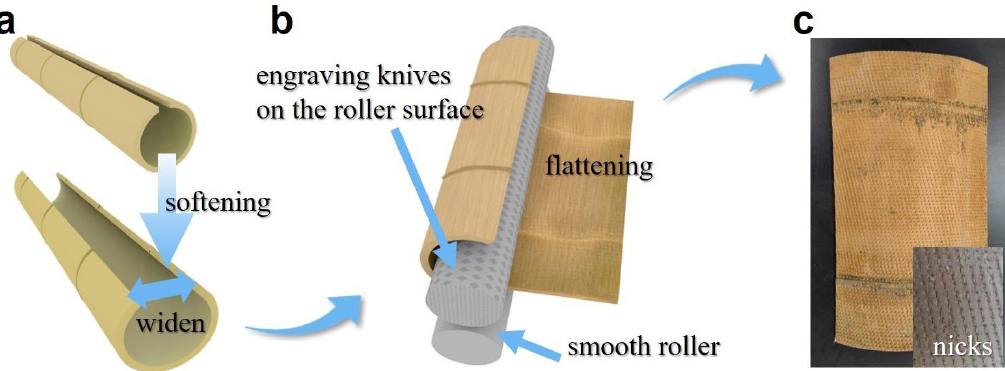
Figure 2. Schematic diagrams of ( a ) bamboo softening and ( b ) flattening; ( c ) the physical picture of the FBB inner surface and the enlarged view in the lower-right corner .